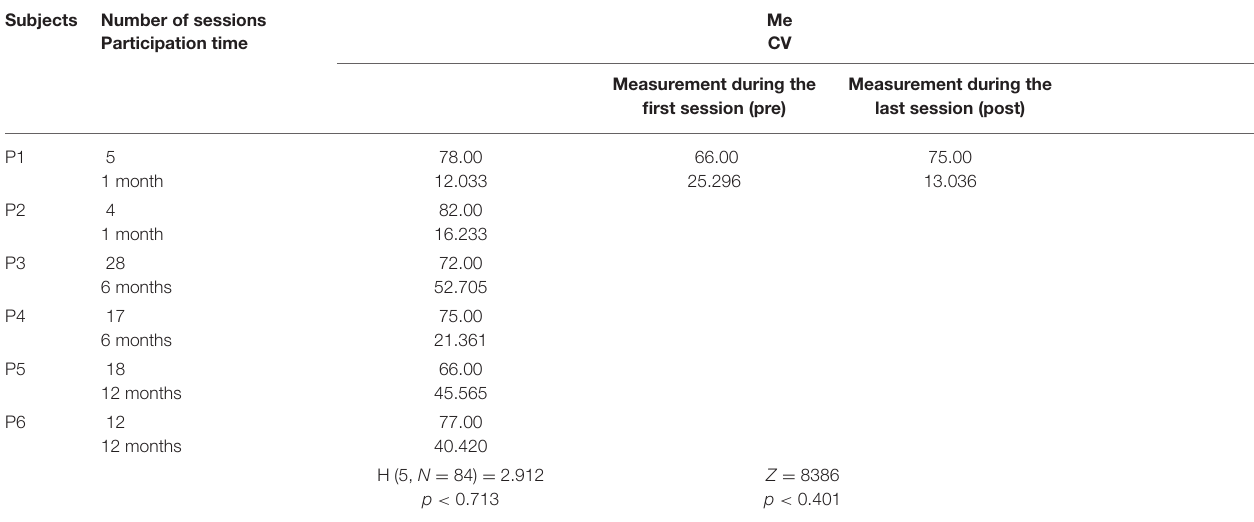
TABLE 3 | Results of statistical analyses: Me, CV, Kruskal-Wallis ANOVA, Wilcoxon paired order test. Subjects Number of sessions Participation